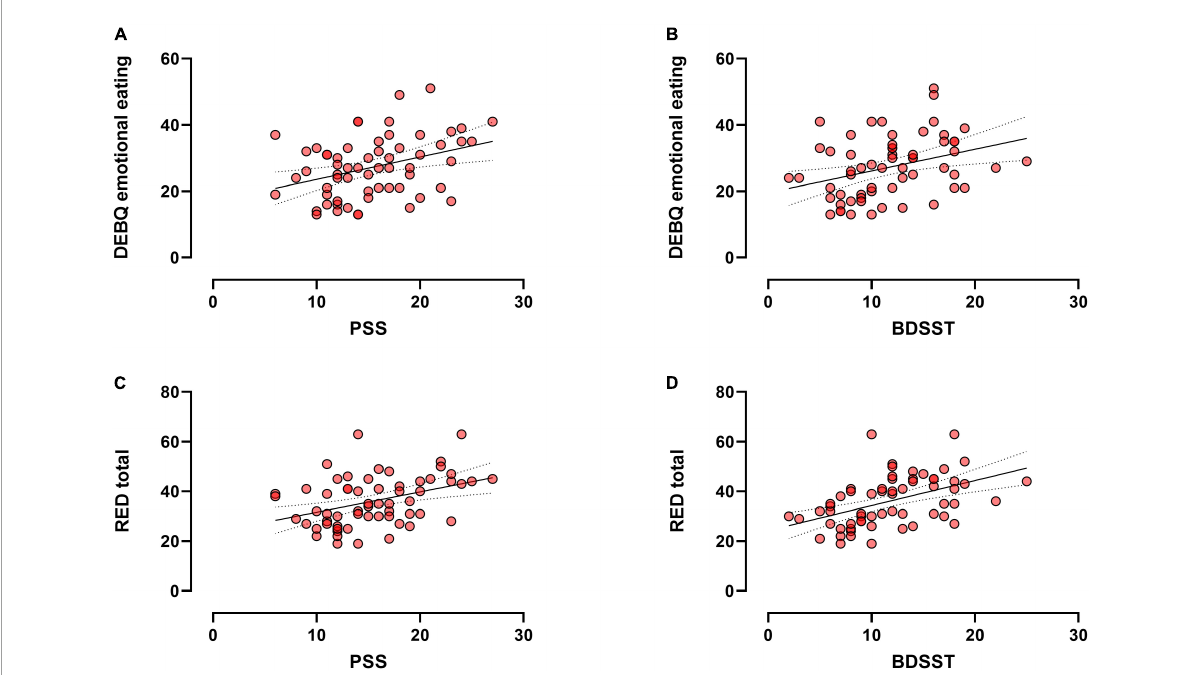
FIGURE1 Scatter plot ( N = 61) showing significant correlations between the DEBQ emotional and PSS (A) or BDSST (B) ; and the significant correlations between the RED total score and PSS (C) or BDSST (D) .